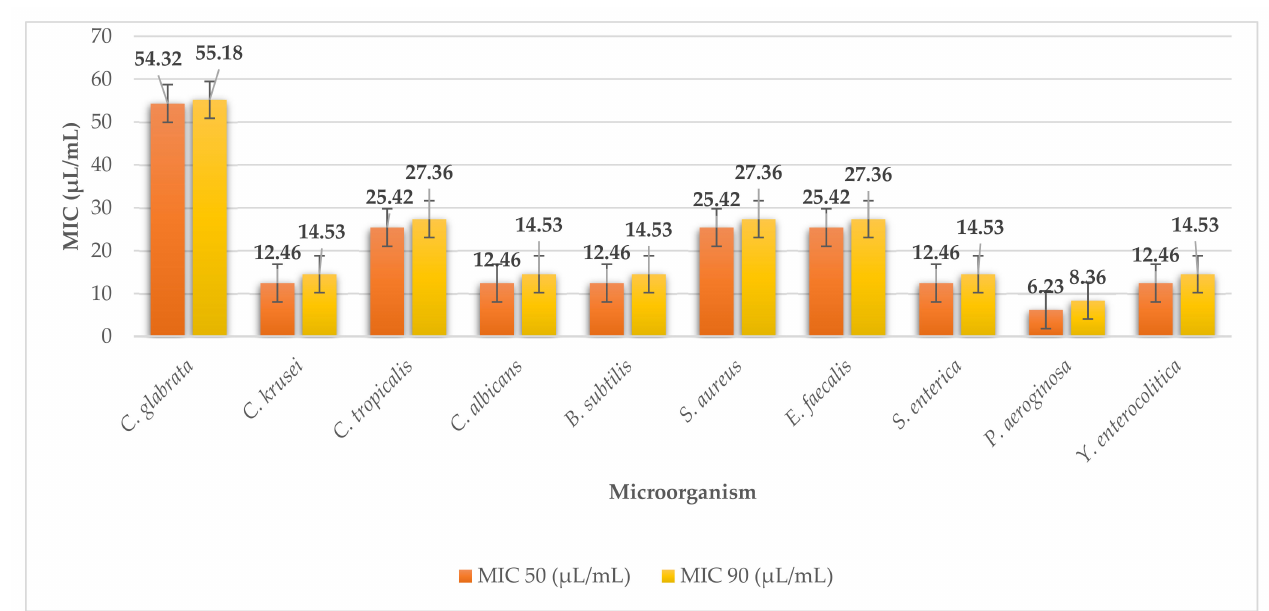
Figure 8. MIC 50 and MIC 90 of dulse.